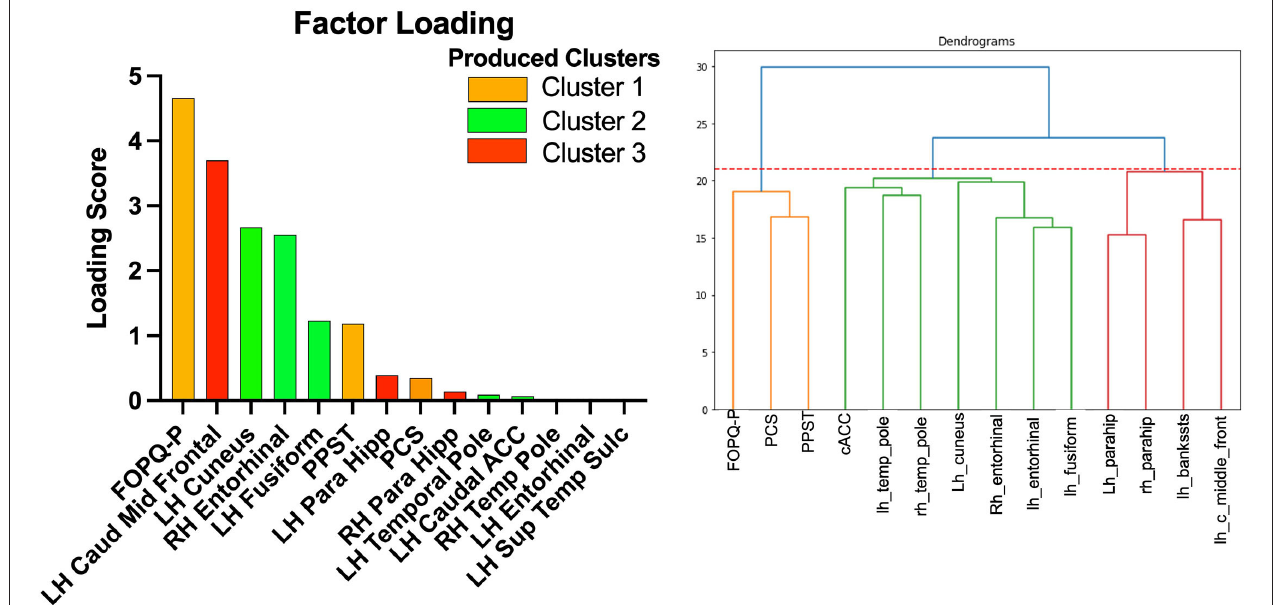
FIGURE 4 | Factor loading (left) and dendrogram (right) showing the clustering of the 14 selected variables. The orange cluster is the psychological data. The green cluster is cluster 2 and the red cluster is cluster 1.